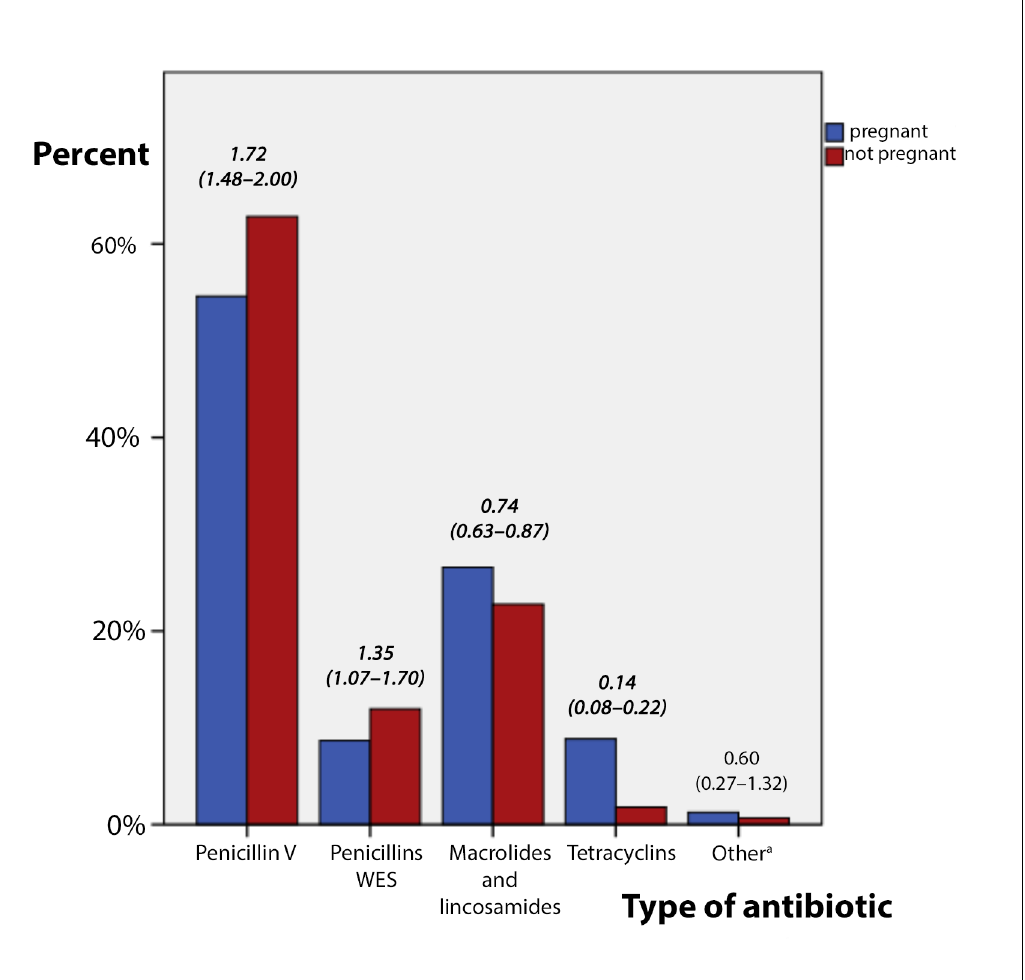
Figure 3. Antibiotic prescriptions for URTIs in patients who were pregnant during study period showing adjusted odds ratio for ’pregnant’ and 95% confidence intervals, (significant difference in bold and italic, P <0.05). N = 18 890 episodes. a Ciprofloxacin and cephalosporins.